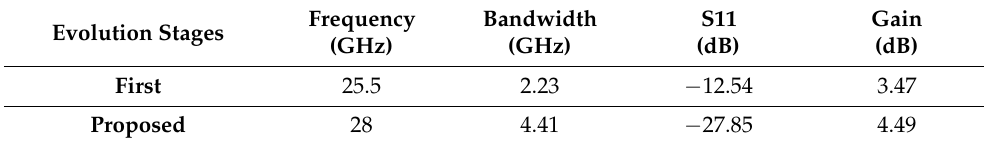
Figure 4. Reflection coefficient of the basic and proposed antenna.